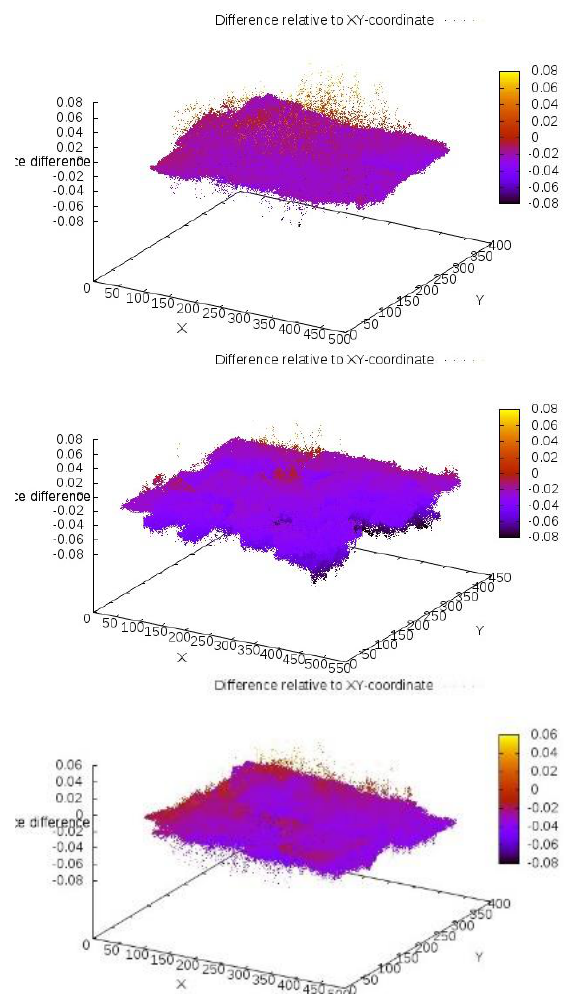
Figure 7. Difference distribution of each sensor in XY-plane